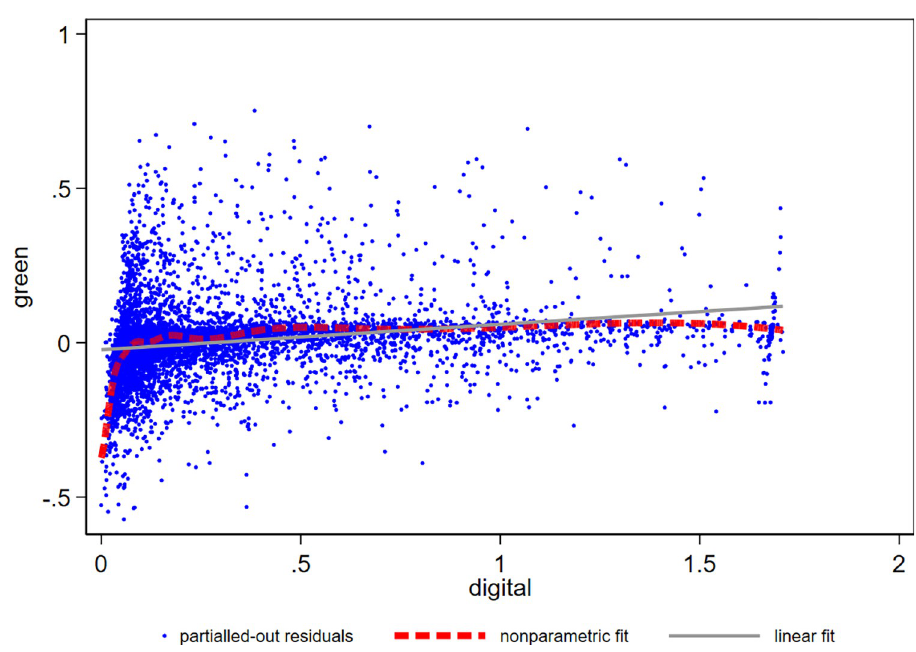
Fig 2. Nonparametric matching of the impact of enterprise digital transformation.